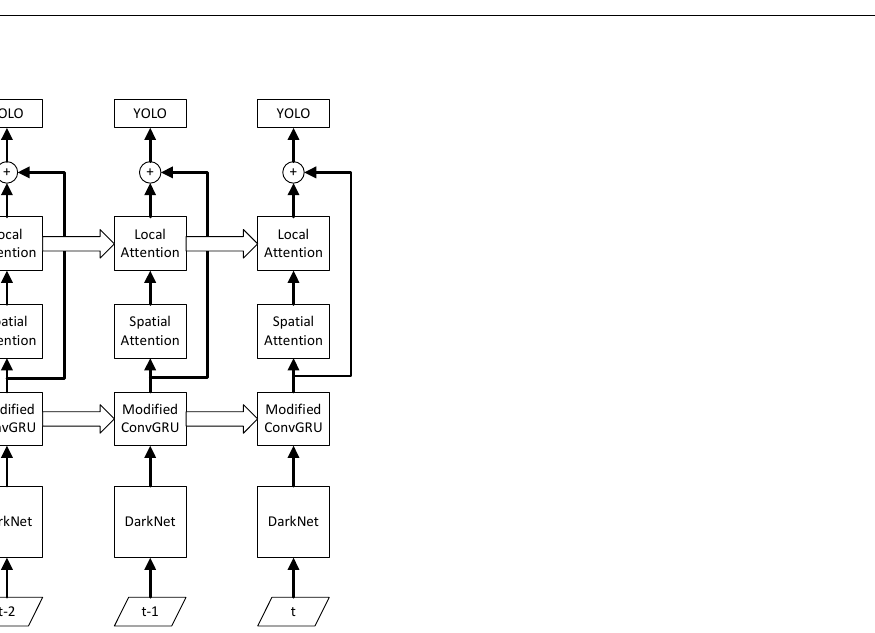
Figure 1. Pipeline of the proposed video object detection framework. Only three frames are shown for simplicity.